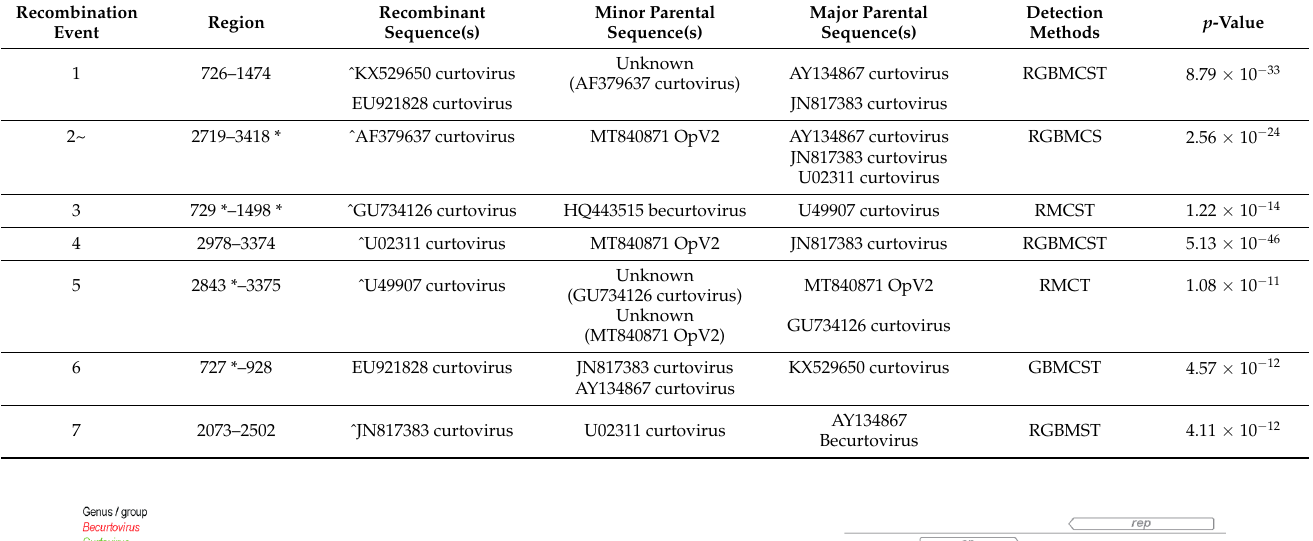
Table 4. Summary of the seven recombination events from a dataset of representative sequences of OpV2 and Opuntia becurtovirus, with representatives from the genera Becurtoviru s and Curtovirus , as detected by RDP5 5.5 [63]. The methods used to detect recombination were RDP (R) GENCONV (G), BOOTSCAN (B), MAXCHI (M), CHIMERA (C), SISCAN (S), and 3SEQ (T). The method with the highest p -value for each recombination event is bolded. Sites where the actual breakpoint is undetermined are marked with *. Recombinant sequences marked with ˆ indicate that the recombinant sequence may have been misidentified (one of the identified parents might be the recombinant).